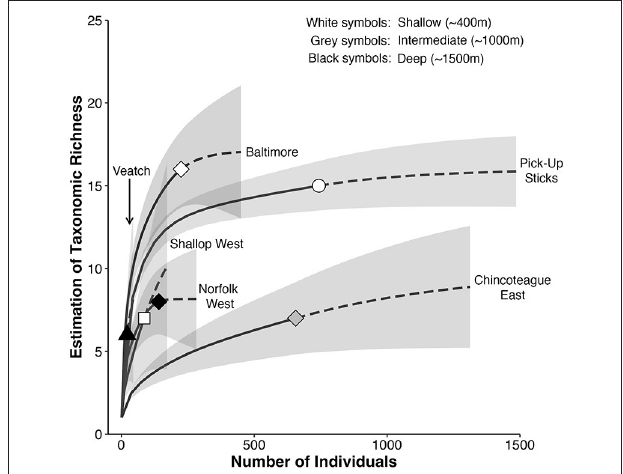
FIGURE 4 | Taxonomic richness (rarefaction and extrapolation) estimates from photo transect data. Solid lines: interpolated results, dotted lines: extrapolated results, each with 95% confidence intervals. Symbols: observed